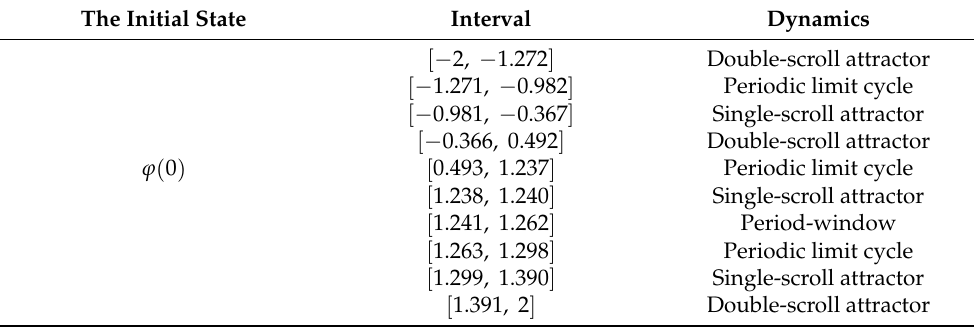
Figure 16. Dynamics analysis with initial state ϕ ( 0 ) : ( a ) Lyapunov exponents spectrum; ( b ) bifurca- tion diagram. Table 2. The complex dynamical behavior with the change of Initial state ϕ ( 0